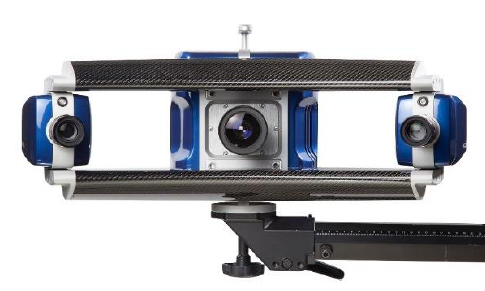
Figure 5: Breuckmann